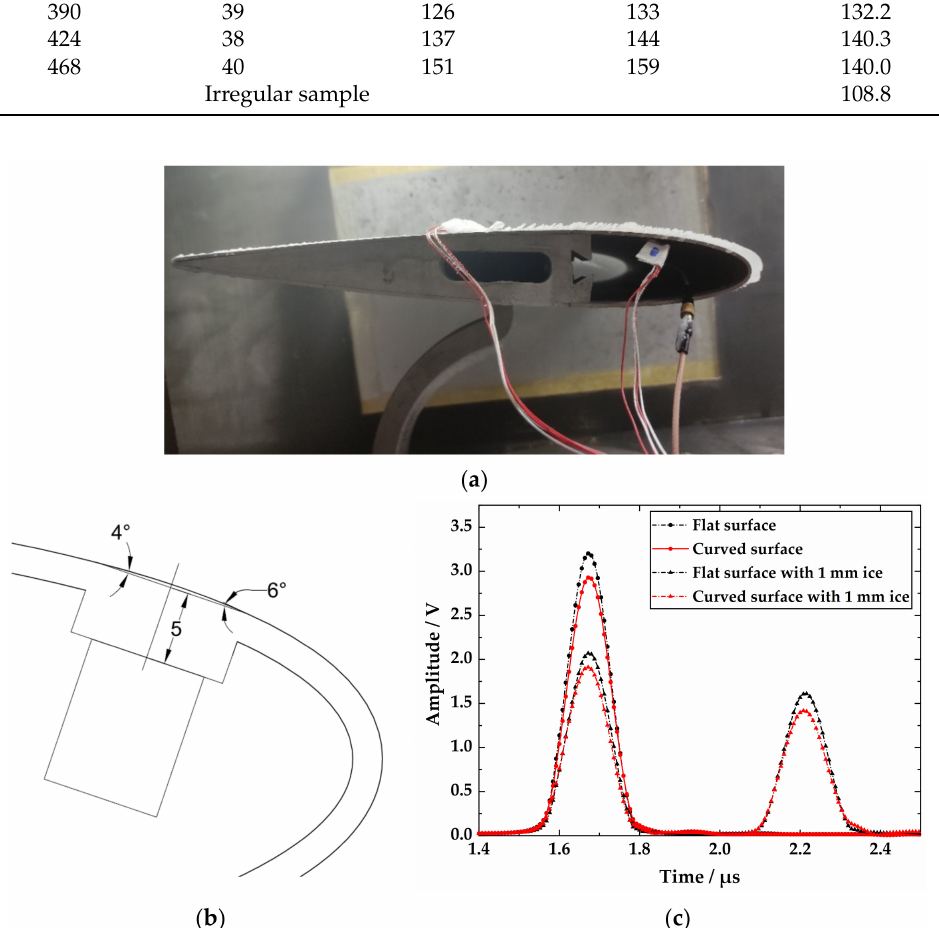
Figure 8. Installation of the ultrasonic transducer on NACA0012 airfoil model: ( a ) airfoil model in the icing wind tunnel, ( b ) schematic diagram of the transducer’s installation position, and ( c ) the envelopes of